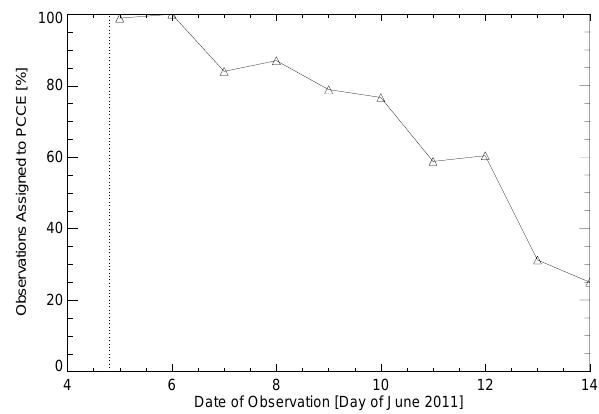
Fig. 6. Percentage of IASI observations per day that could be as- signed to the PCCE source. The given dates refer to the date of observation. The dotted line indicates the onset of the eruption on 4 June 2011 at